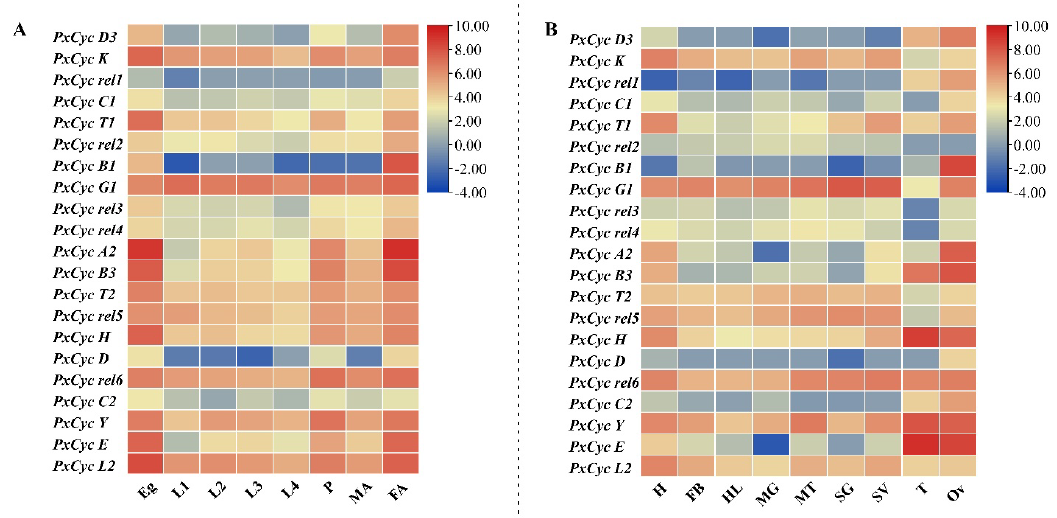
Figure 6. Heat map of transcriptomic expression profiling of cyclin genes at various stages and tissues. ( A ), the expression profile at various stages; ( B ), the expression profile of cyclin genes in different tissues. Log 2 transformed FPKM values were used for the heatmap construction. Eg, egg; L1, first-instar larva; L2, second-instar larva; L3, third-instar larva; L4-F, fourth-instar female larva; L4-M, fourth-instar male larva; P-F, female pupa; P-M, male pupa; A-M, adult male; A-F, adult female; HD, head; FB, fat body; HL, hemolymph; MG, midgut; MT; malpighian tubule; SG, silk gland; SV, salivary gland; TE, testis; OV, ovary.